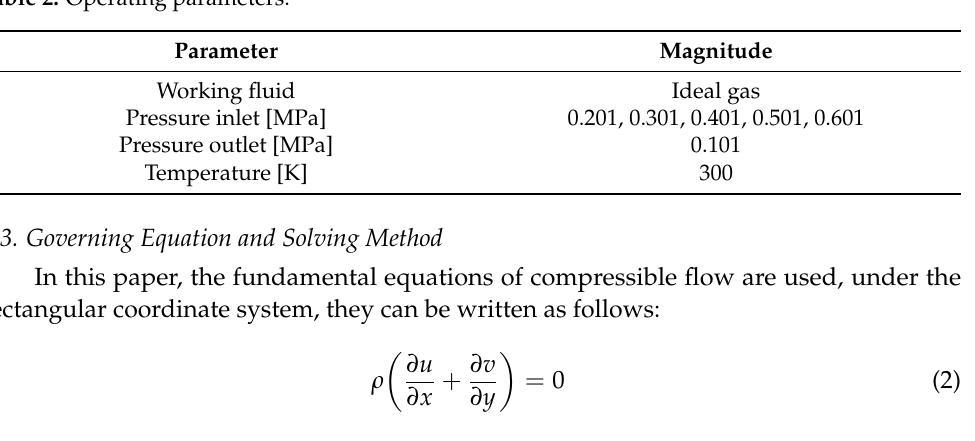
Table 2. Operating